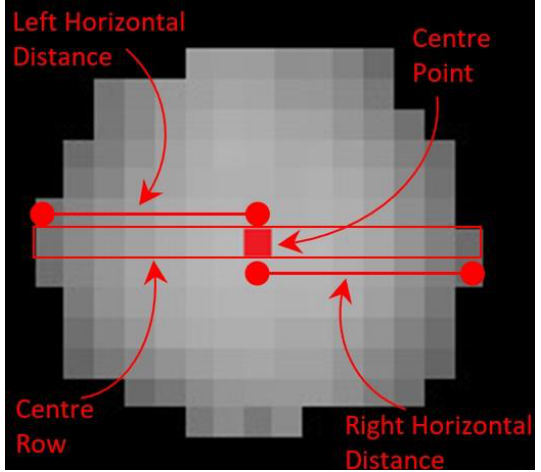
Figure 9. Distribution of image pixels with labelling of center point, center row and horizontal distances from center point to the horizontal extremes.